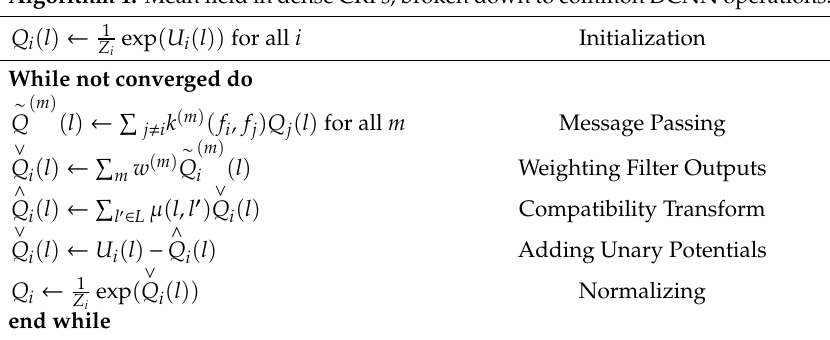
Table 1. Mean-field approximation reasoning iterative algorithm. Algorithm 1. Mean field in dense CRFs, broken down to common DCNN